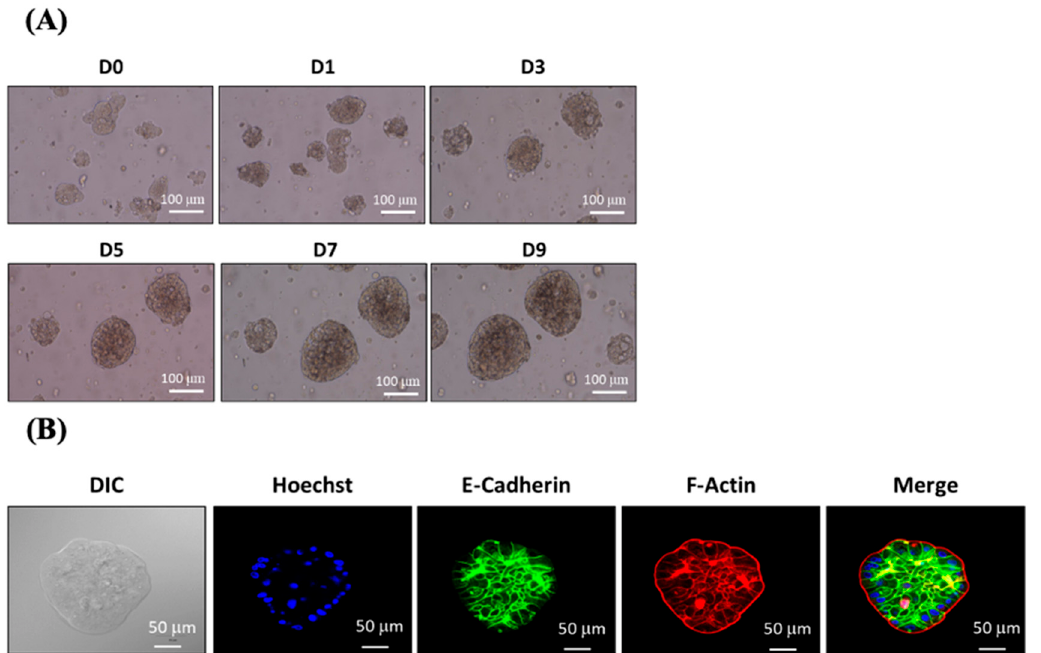
Figure 5. Primary colon cancer cells from patient-derived tissue samples were grown using the ACD 3D culture system. ( A ) Primary colon cancer cells obtained from patient-derived tissue samples were trypsinized and cultured using the ACD 3D culture system for 9 days. Bright-field images show the morphologies of spheroids grown in the ACD 3D culture system on Days 0, 1, 3, 5, 7, and 9. Images were captured using a phase-contrast microscope. Scale bar = 100 μ m. ( B ) The expression of cancer markers E-Cadherin and F-actin in primary colon cancer tumoroids. Tumoroids isolated from ACD 3D culture system gels were subjected to immunofluorescent staining. Images were cap- tured using a laser scanning confocal microscope at the magnification of 400×. Blue: Hoechst 33258; green: E-Cadherin; red: F-actin. Data shown from triplicate independent experiments.